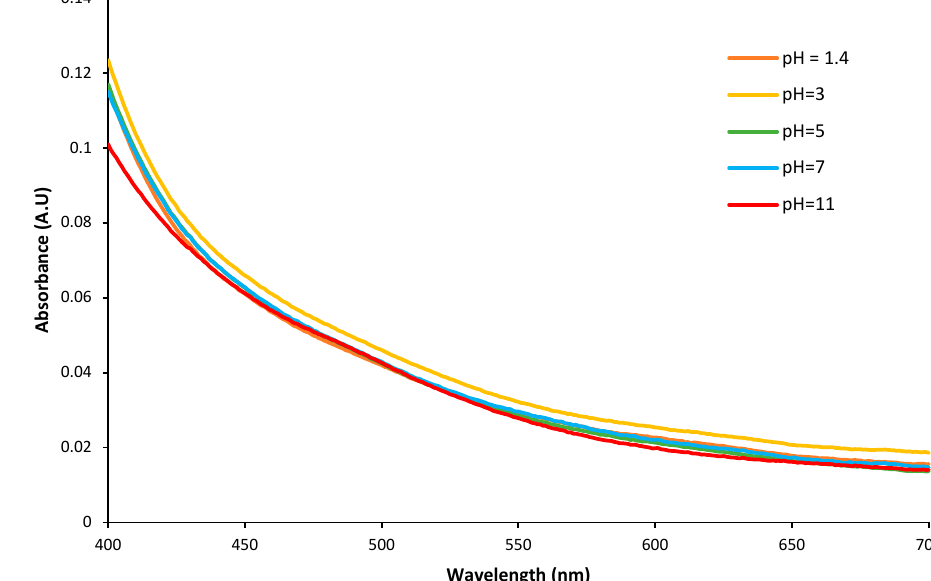
Figure 2. UV-visible spectra of colloidal suspensions of AuNPs (at 0.1 g.L − 1 ) at different pH.